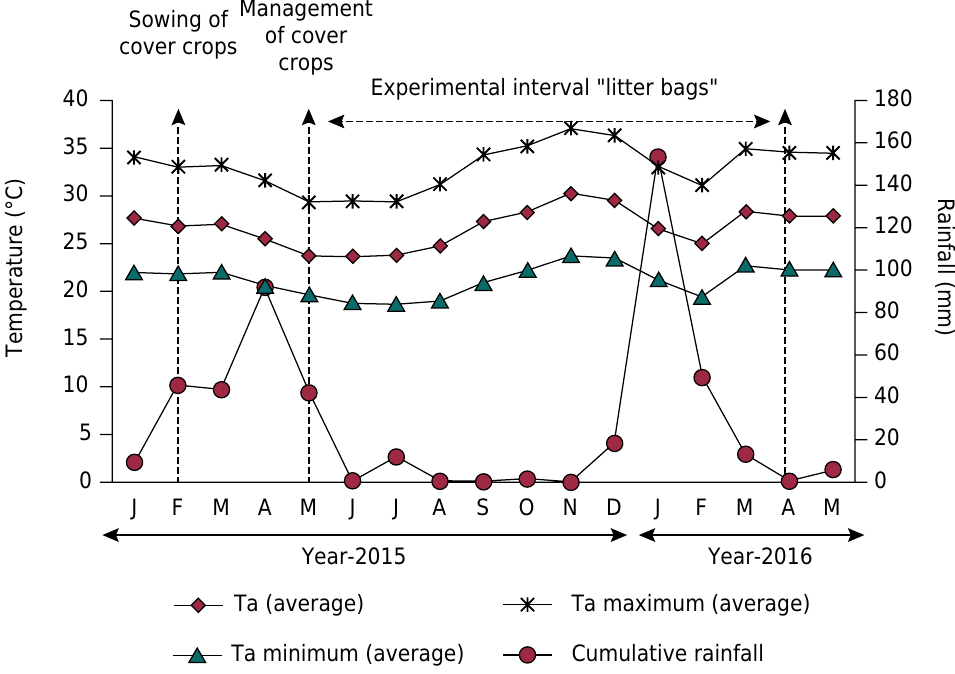
Figure 1. Monthly average air temperature (minimum, mean, and maximum) and cumulative rainfall during the growth period and after management of the cover crops (February 2015 to April 2016). Data of the Agrometeorological Station of Embrapa Semi-Arid Agriculture, Petrolina, Pernambuco,